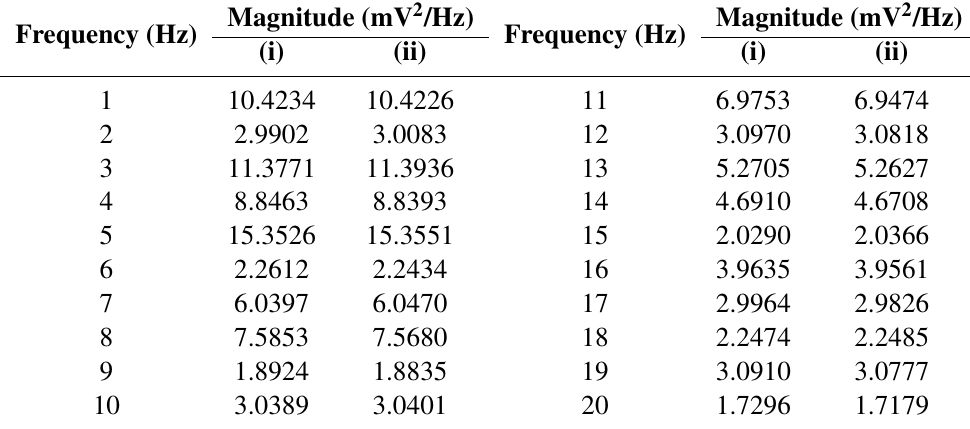
Table 4. FFT peak magnitudes of ECG when ECG front-end circuit is powered using: (i) a direct external 1.8 V power supply; and (ii) a regulated 1.8 V from the integrated DC-DC converter discussed in Section